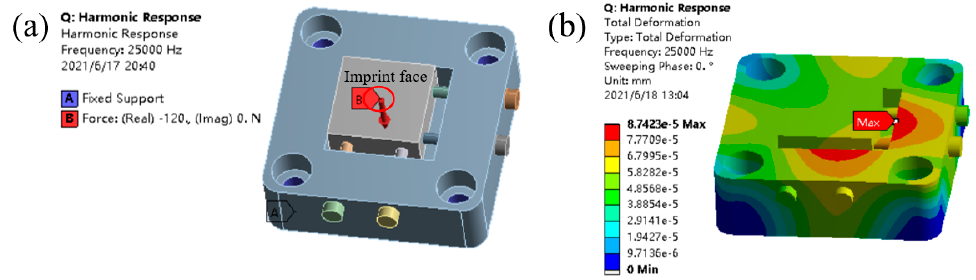
Figure 8. Harmonic response analysis of the workpiece fixture. ( a ) Load and constraint; ( b ) Defor-